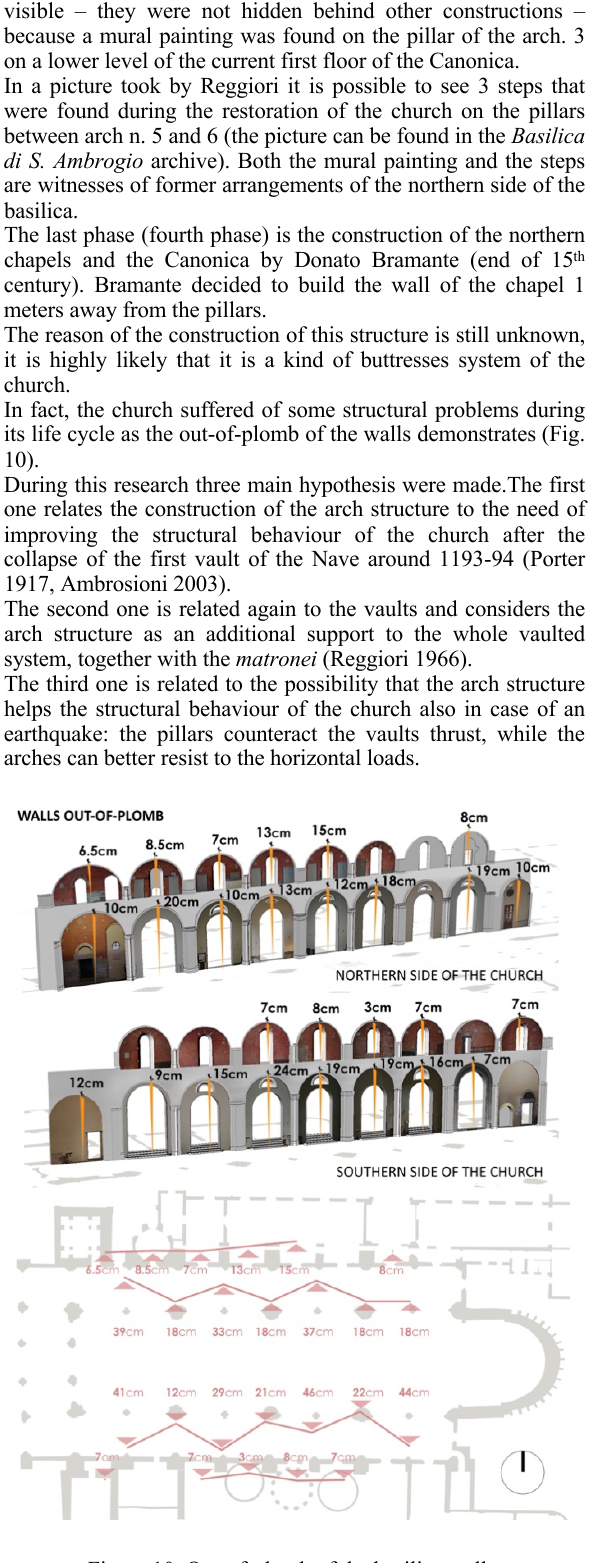
Figure 10. Out-of-plomb of the basilica